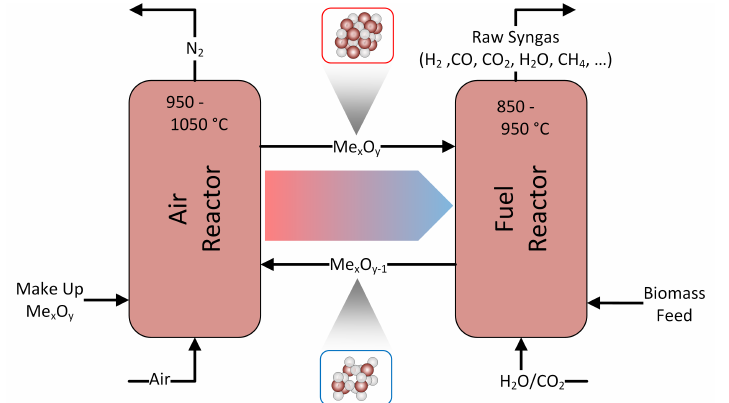
Figure 1. Schematic of the CLG process showing the cyclic reduction and oxidation of an OC material which is oxidized in the air reactor (AR) and reduced in the fuel reactor